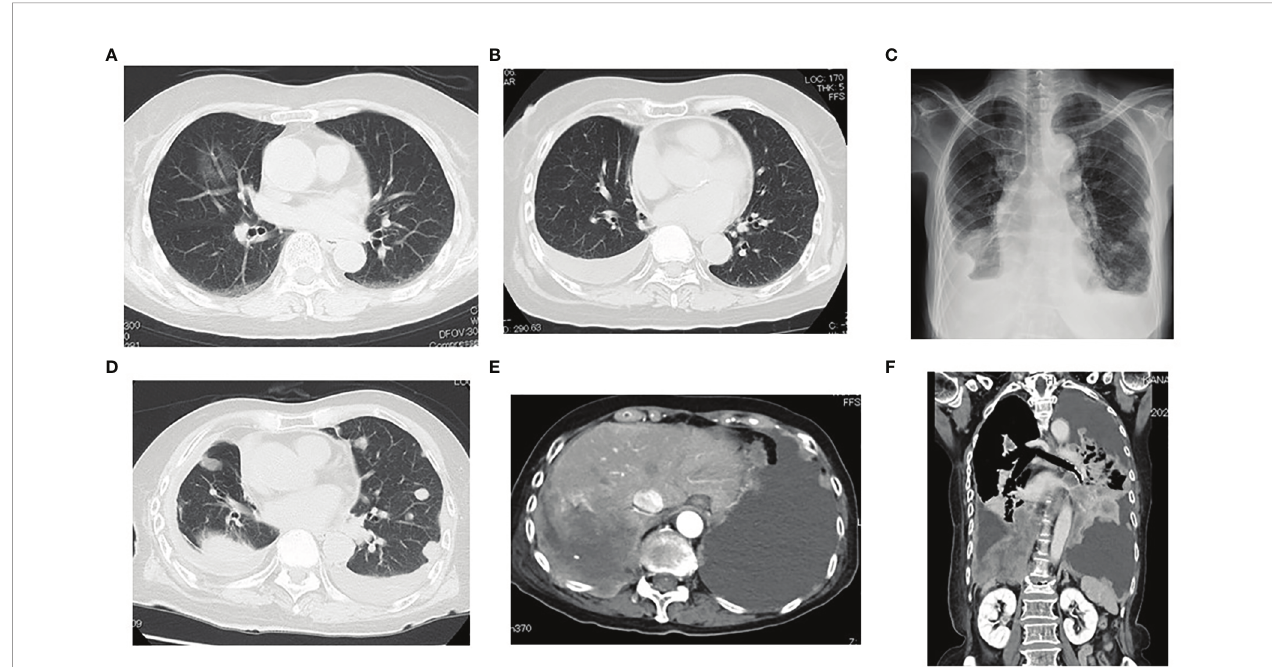
FIGURE 1 | (A) Chest CT showing a ground glass opacity of 32 mm in size in her middle lobe of the right lung. (B) At 2 years and 3 months after pulmonary resection, the follow-up chest CT revealed right pleural effusion. (C – F) At 4 year and 7 months after pulmonary resection, the chest CT revealed multiple pulmonary nodules and bilateral pleural effusion with a right pleural tumor directly invading into the abdominal cavity. A right malignant pleural mesothelioma (sarcomatoid type) invaded to the right adrenal gland and the